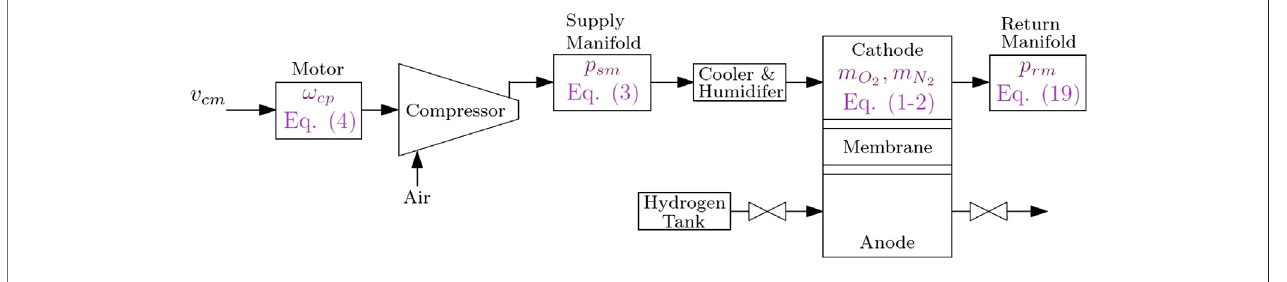
FIGURE 1 | Illustrative diagram of the fi ve-states fuel cell system